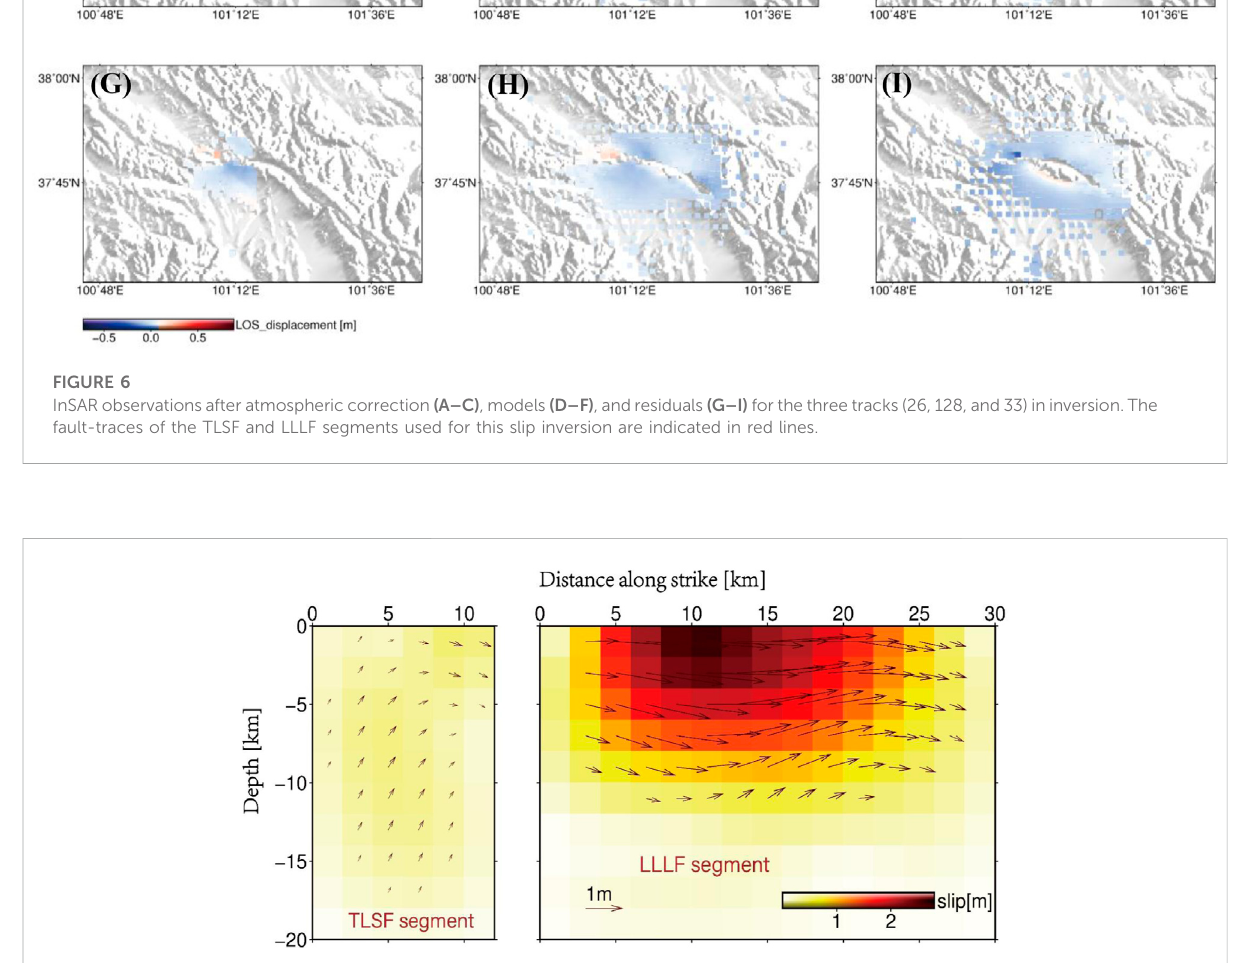
Frontiers in Earth